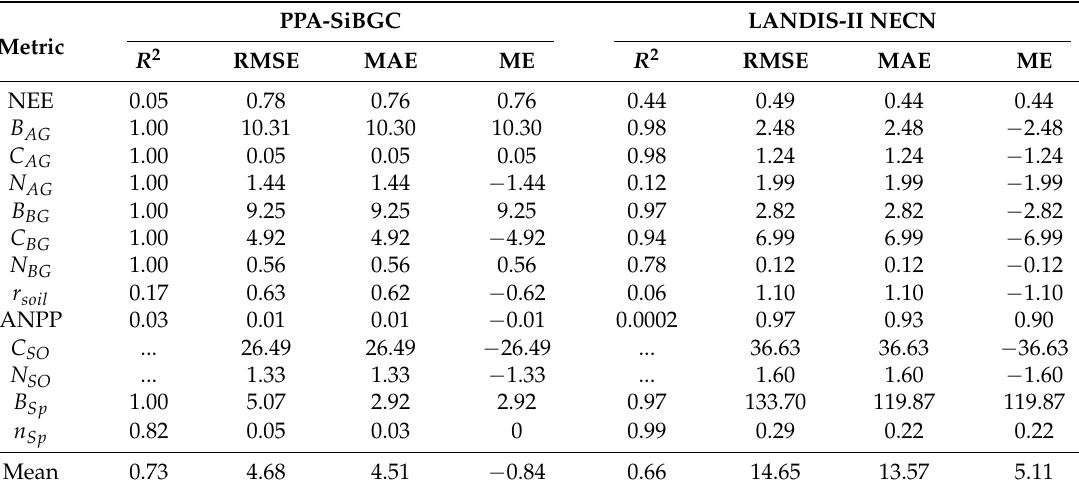
Table 7. Model fitness for HF-EMS.